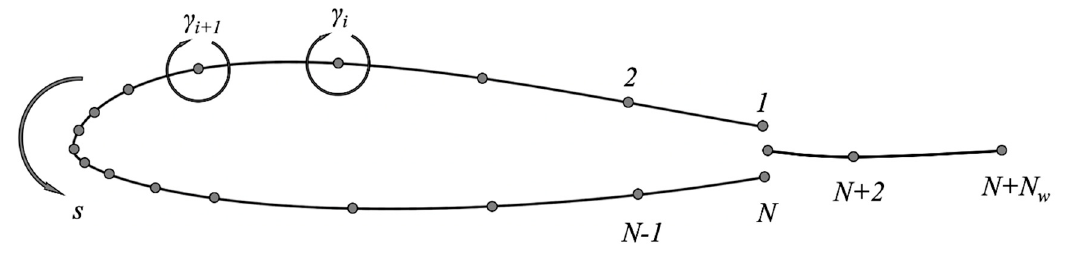
Figure 6. Demonstration of the panel method analysis [28].